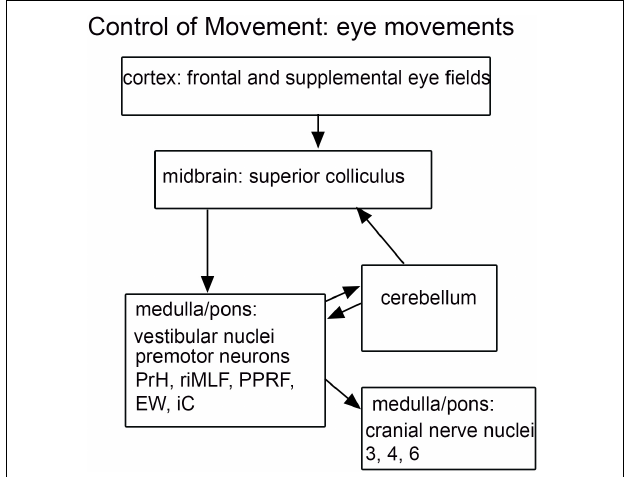
FIGURE 4 | Schematic of brainstem nuclei critical for eye movement control. Cranial nerve nuclei 3-oculomotor, 4-trochlear, 6-abducens; EW, Edinger-Westphal nucleus; iC, interstitial nucleus of Cajal; PrH, nucleus prepositus hypoglossi; PPRF, paramedian pontine reticular formation; riMLF, rostral interstitial nucleus of the medial longitudinal fasciculus; SNr, substantia nigra, pars reticulata.